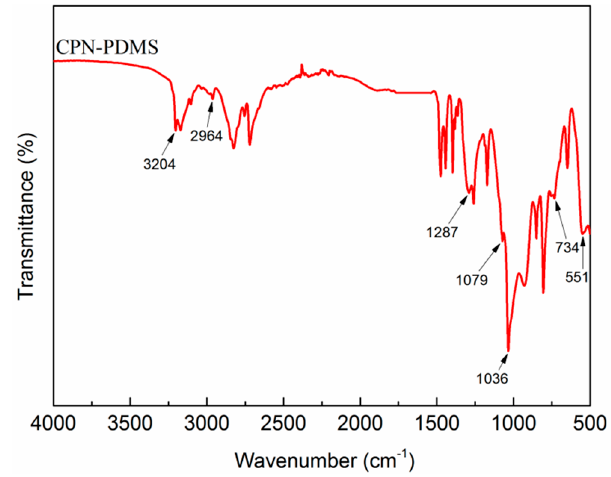
Figure 1. The FTIR spectrum of CPN-PDMS.